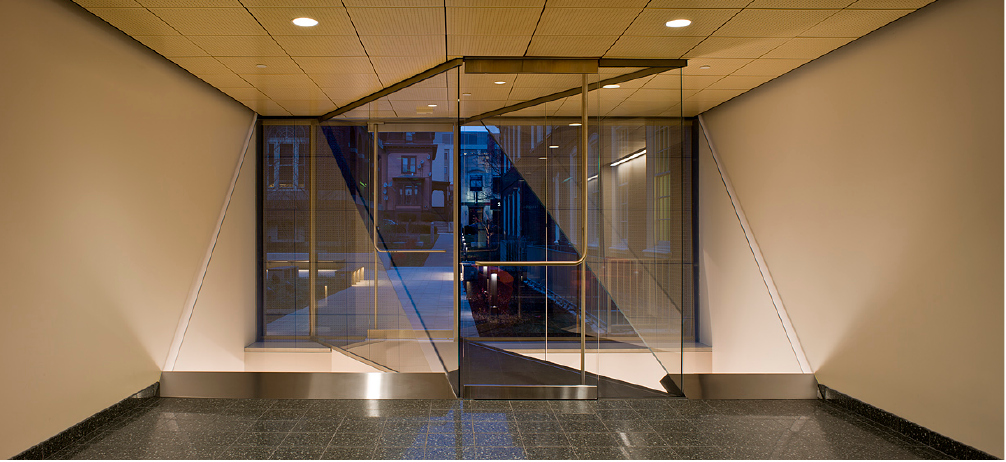
Fig. 3 P-131317, 2011 | Glass and existing architecture | Total dimensions variable Brown University Cognitive Science Building | Providence RI, USA Photo Credit: Warren Jagger | Interior evening